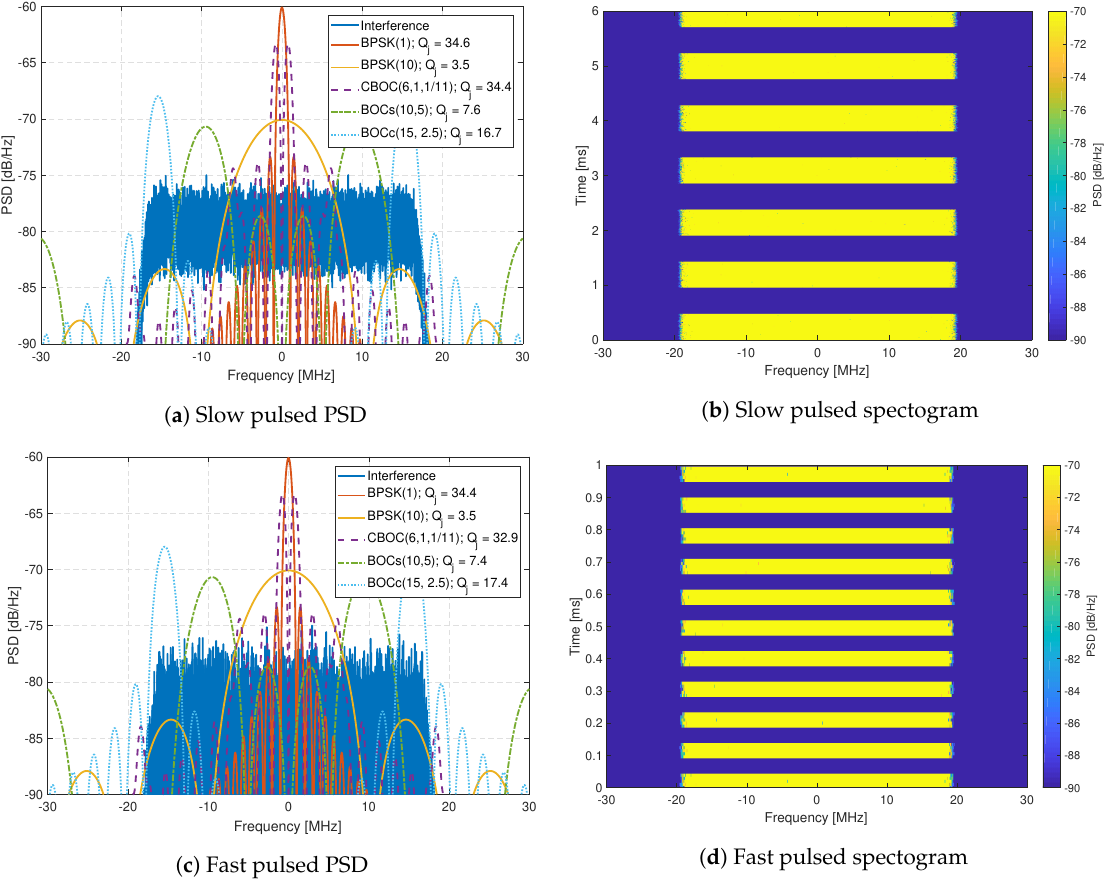
Figure 13. Analysis of pulsed FM